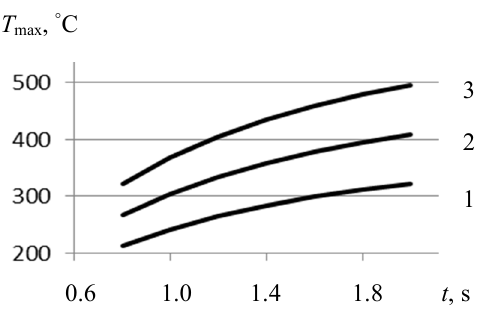
Fig. 4. Dependence of the maximum temperature Т max on heating time t heat at Т ∞ : 1 – 370 °C; 2 – 470 °C; 3 – 570 °C.